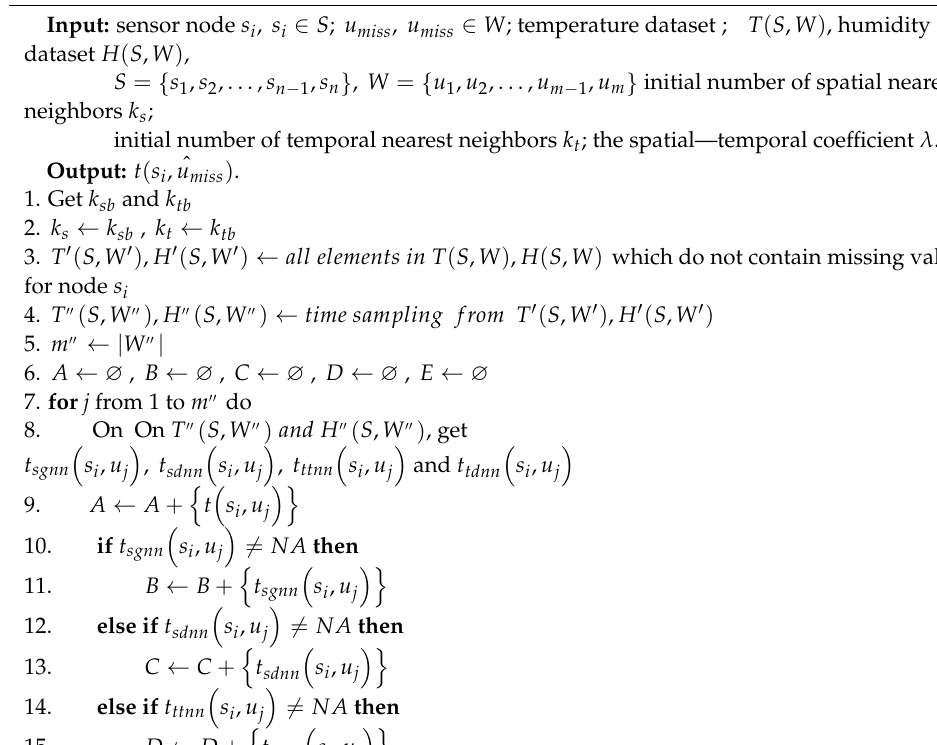
Algorithm 1: TSNN